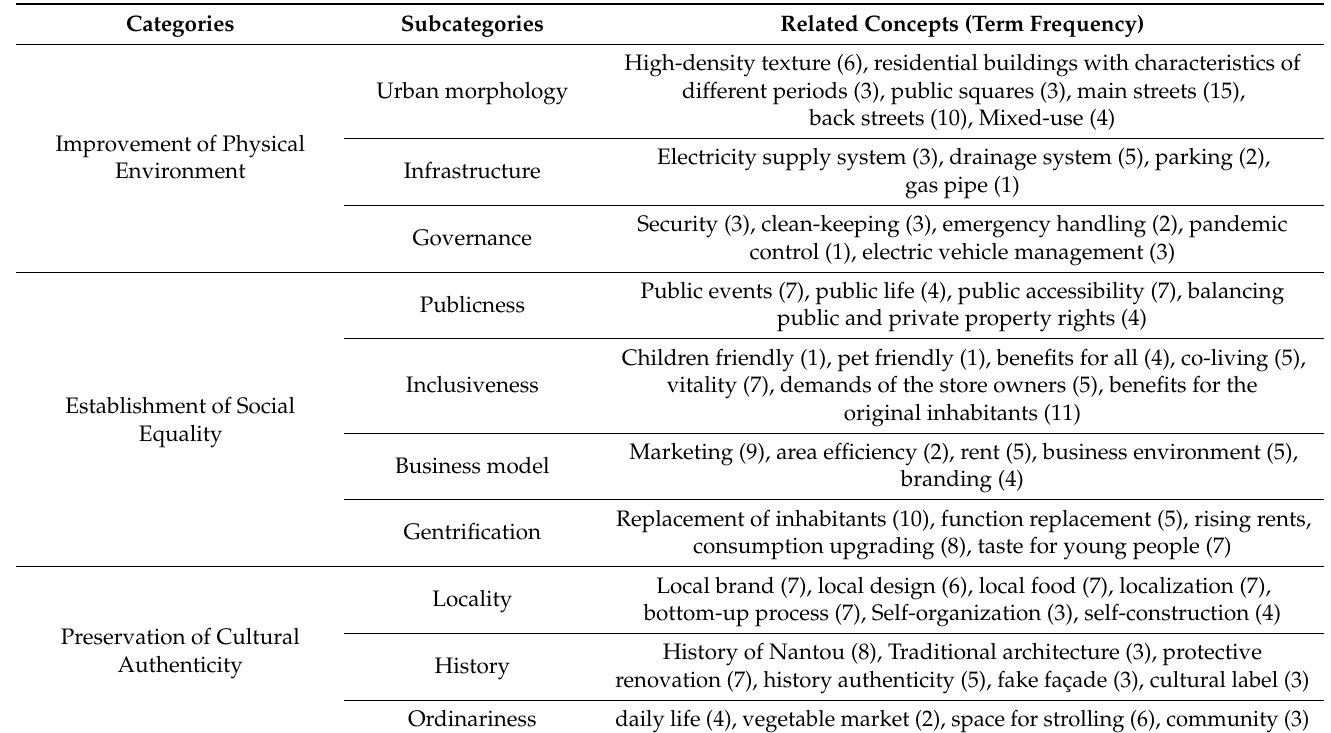
Table 3. Key concepts in the multi-subject evaluation of the effectiveness of Nantou’s